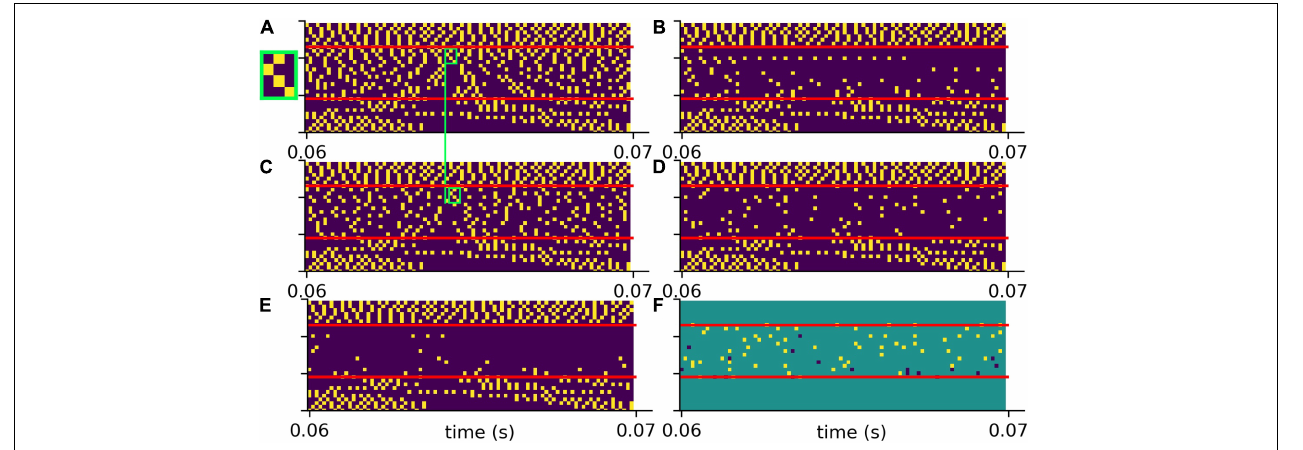
FIGURE 6 | Effect of intrinsic noise on the DCN output patterns. (A) Spiking without HL (same as in Figure 5A ). (B) Spiking with a HL of 30 dB (same as Figure 5G ). (C) Spiking activity with HL and intrinsic noise of optimal intensity. Additional white noise increases spiking activity. (D) Point-to-point comparison of spiking patterns for no HL and with HL and intrinsic noise. Shown are only spikes that occur in both cases, i.e., that are not affected by HL or that are correctly restored by noise. (E) Point-to-point comparison of spiking patterns for no HL with HL and without intrinsic noise. Shown are only spikes that occur in both cases, i.e., that are not affected by HL. (F) Intrinsic noise of optimal intensity not only restores spikes correctly (yellow), but also introduces false positive spikes (dark blue). Intrinsic noise restores spatio-temporal spiking patterns correctly, yet with some temporal shift (green boxes in panels A,C , zoom of spike pattern in green box).